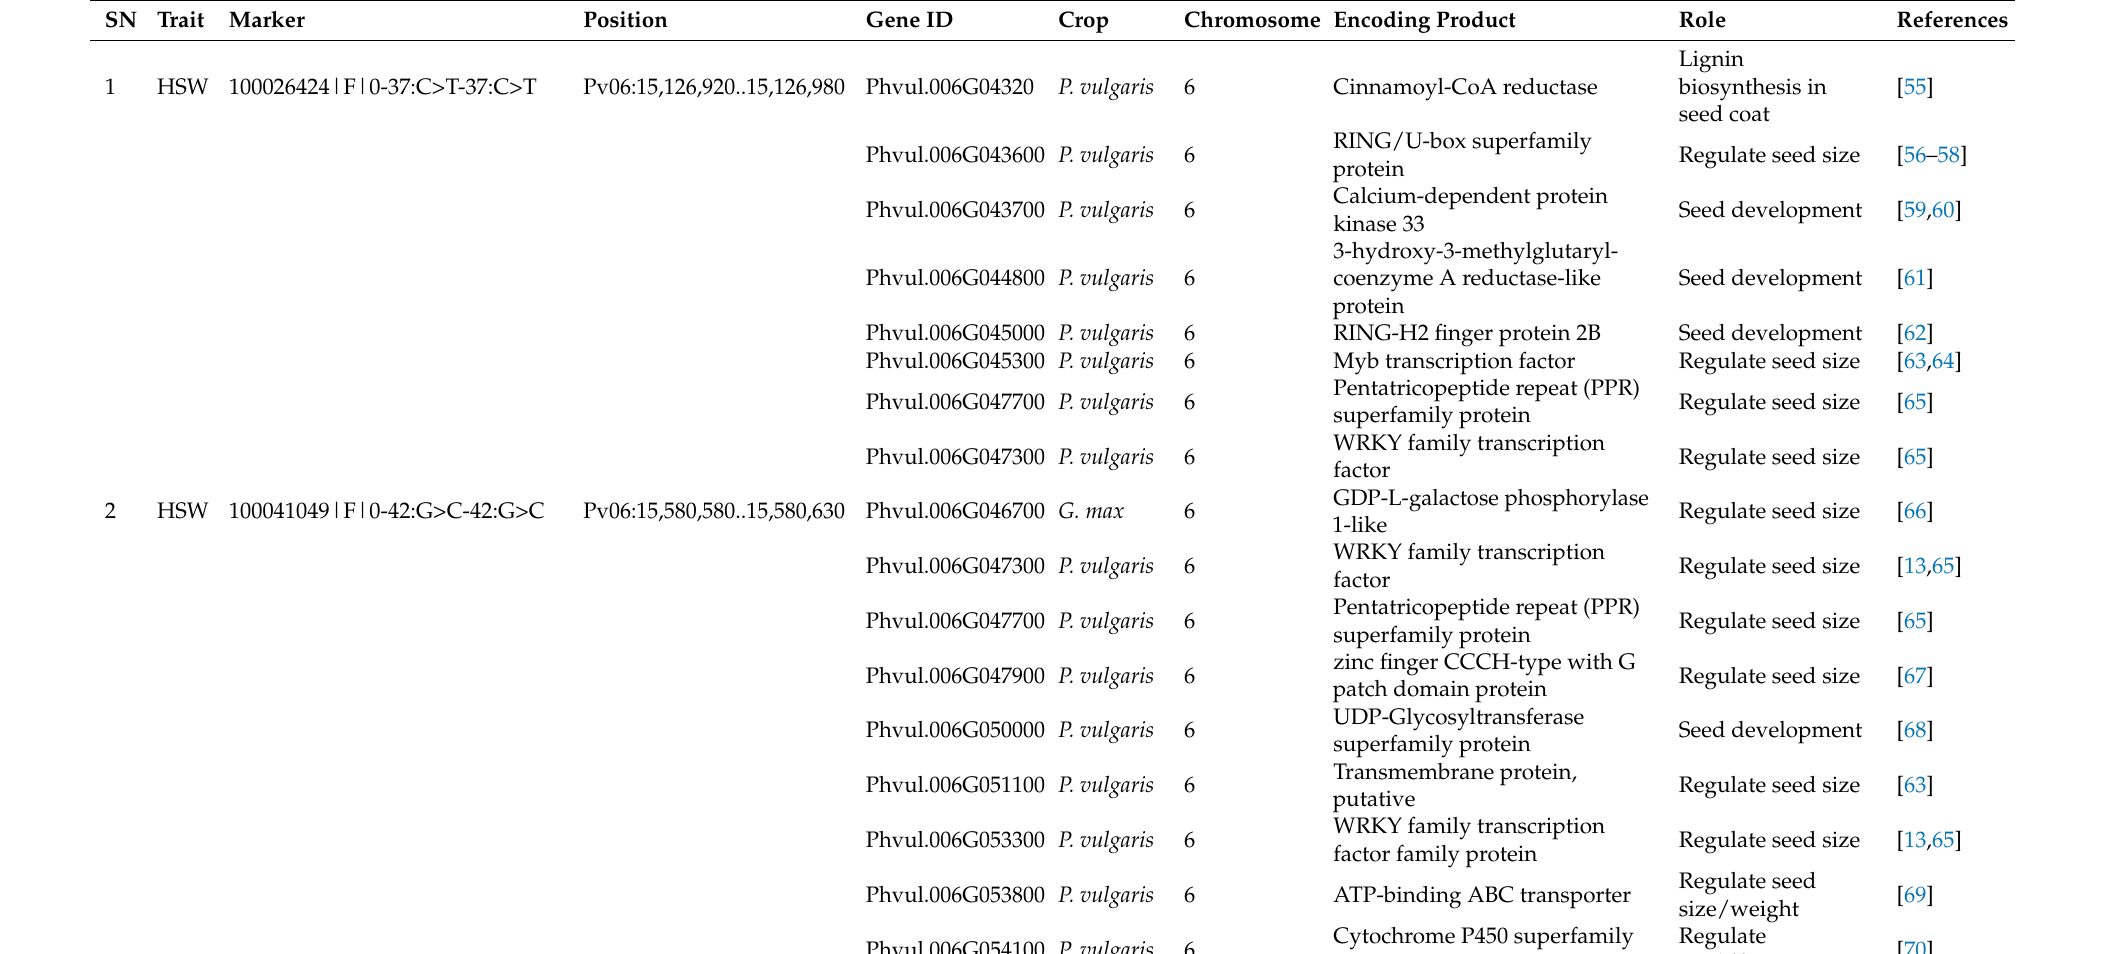
Table 3. Significant markers whose nucleotide sequences were found on the Phaseolus vulgaris genome and the encoding protein of genes found close to